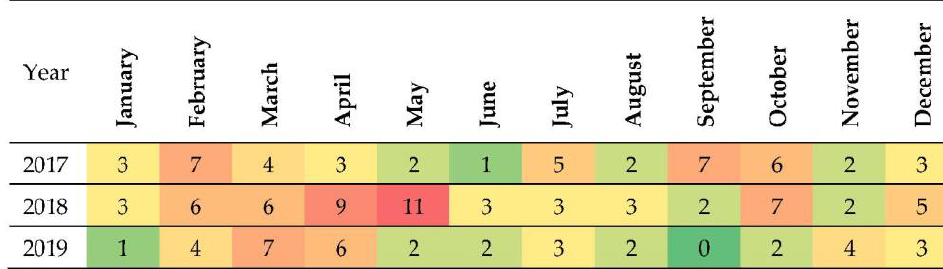
Figure 2. Heat map for incidents per month.